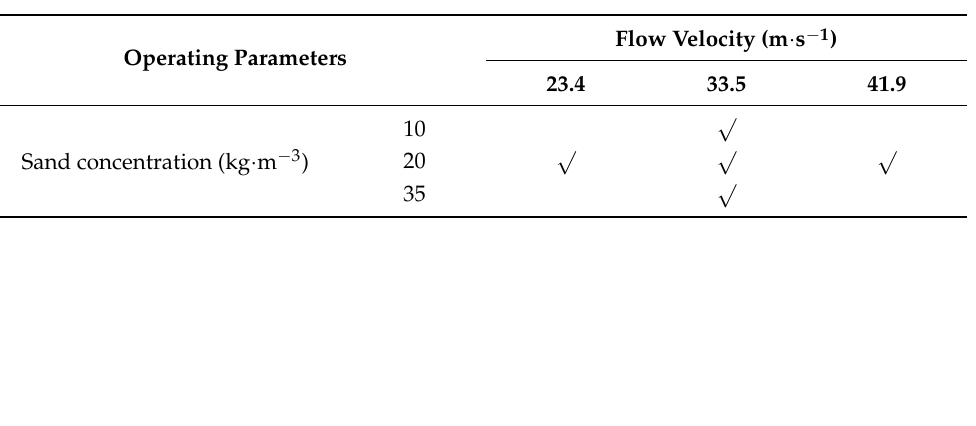
Table 1. Operating parameters of the HAE tests in 3.5 wt.% NaCl aqueous